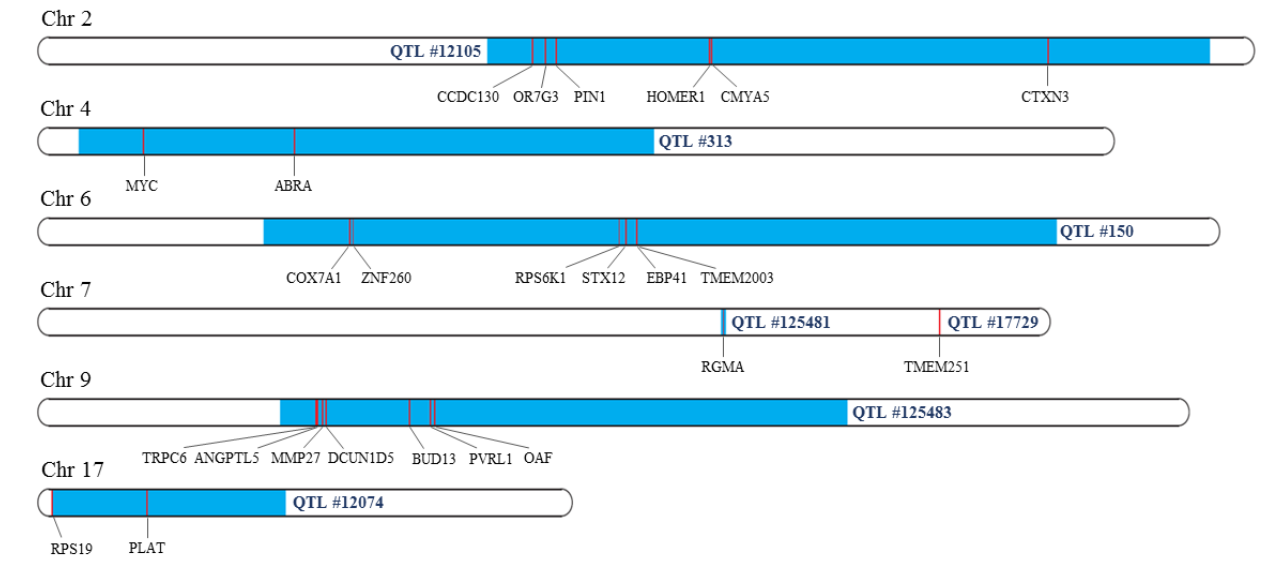
Figure 2. Location of significant genes mapped on quantitative trait loci (QTLs). The light gray areas indicate where genes are located and the dark gray areas indicate QTL